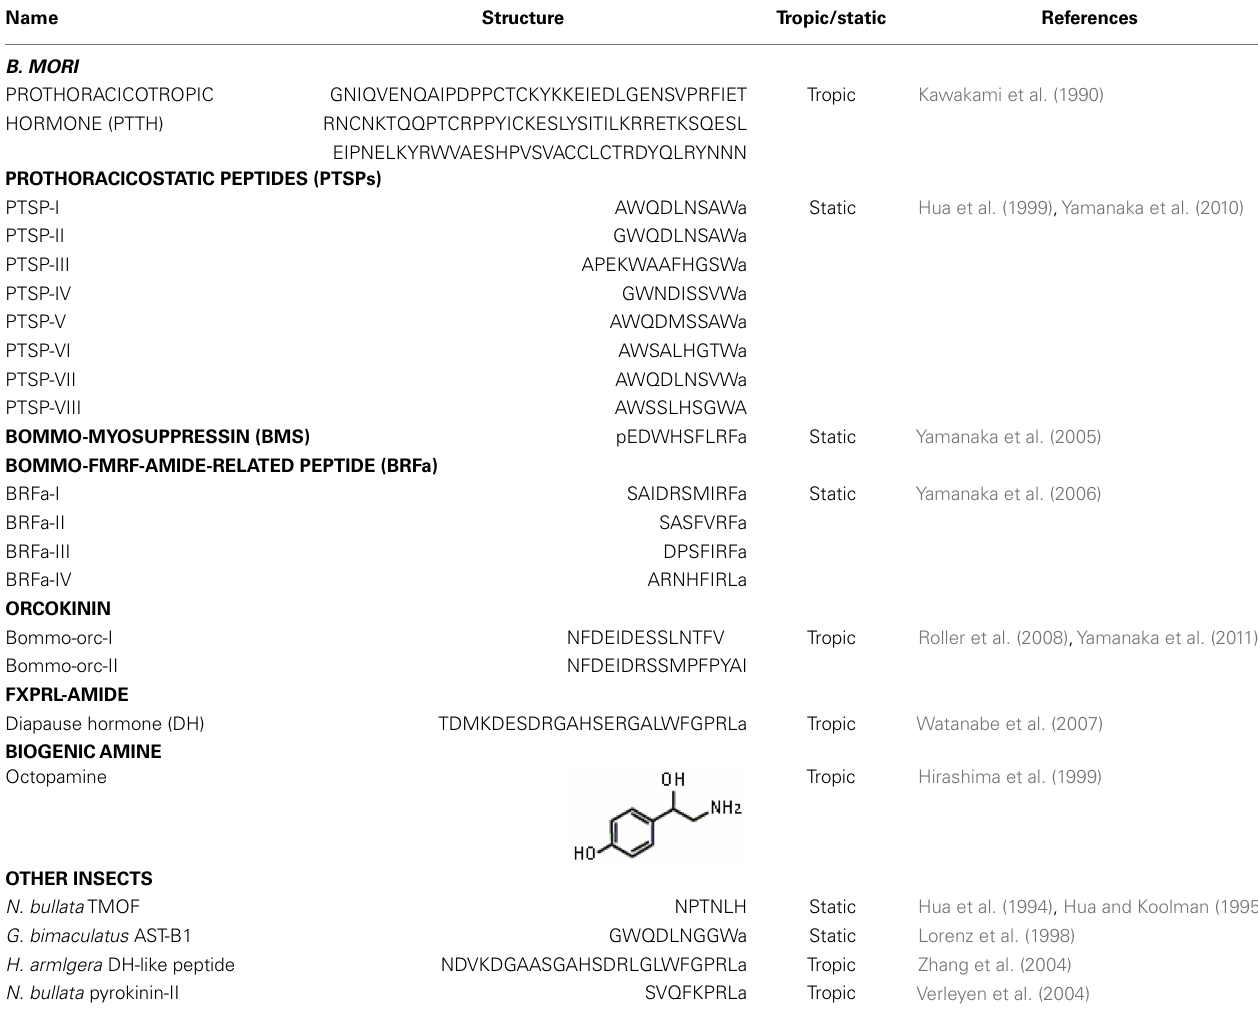
Table 1 | List of peptides and biogenic amine taken up in this